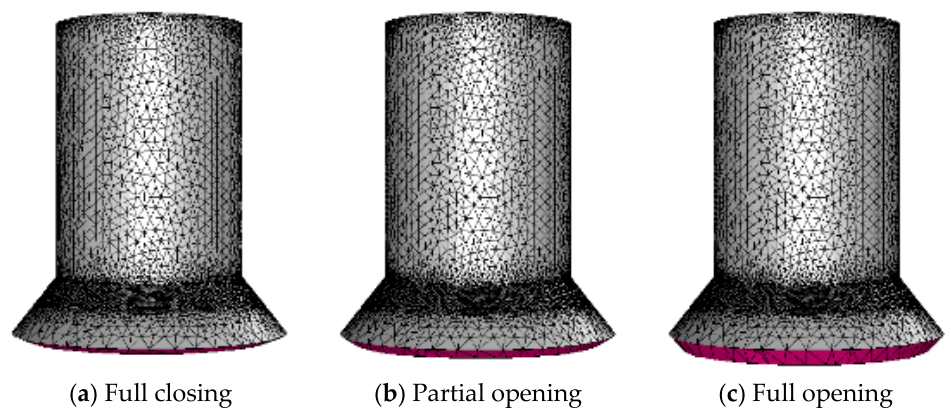
Figure 3. Dynamic mesh of the needle valve for the air-assisted injector.